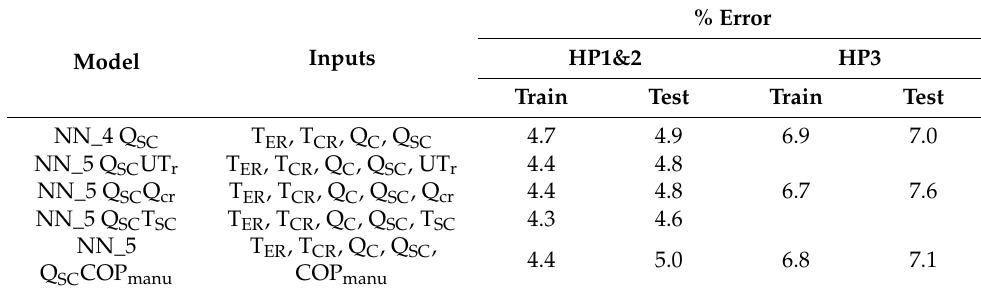
Table 7. Step 2 of forward selection.